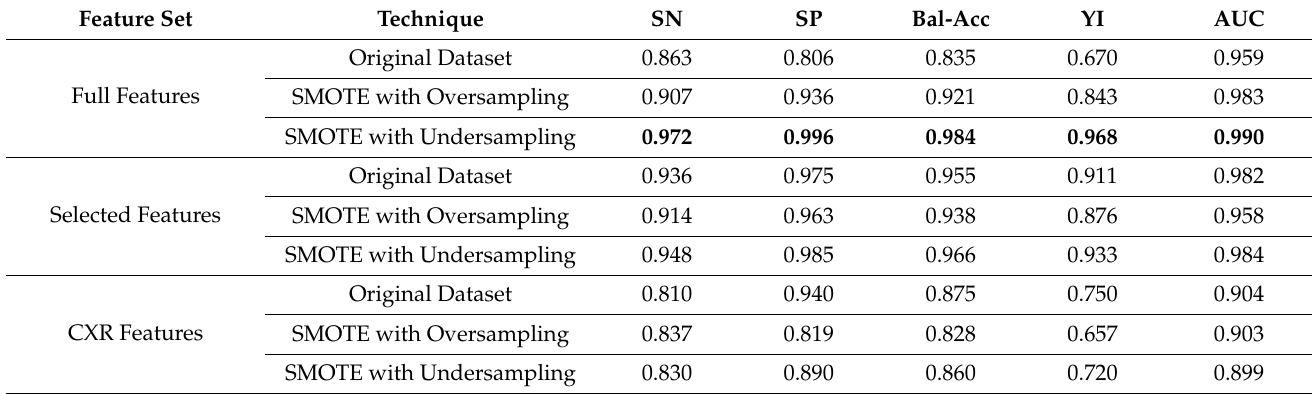
Table 4. Result of the proposed model for ventilator-support prediction (Binary class) (Case